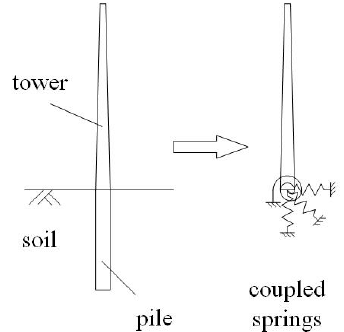
Figure 7. Coupled spring model for the foundation of offshore wind turbine.